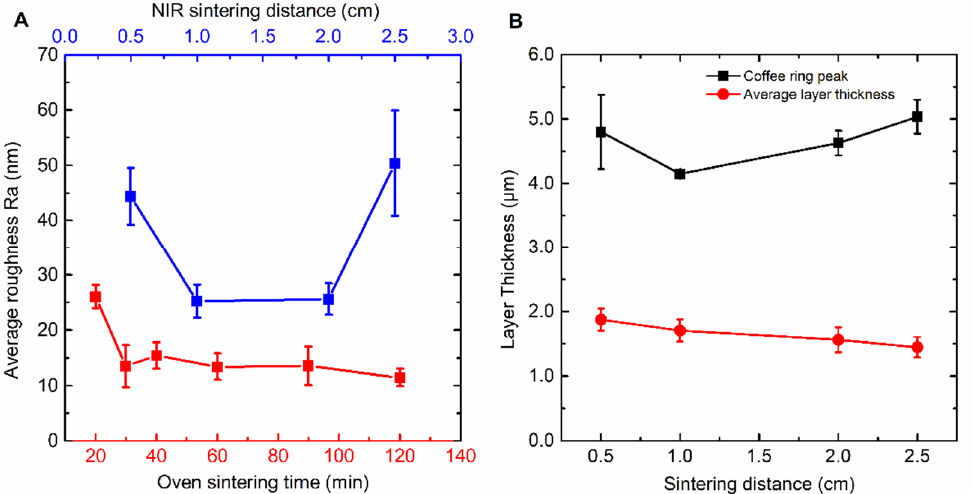
Figure 3. NIR-continuous sintering of JSB40G has an optimal sintering distance of 1 to 2 cm (blue), in order to achieve the lowest average surface roughness (Ra), with slightly higher results compared with conventional oven sintering (red). ( A ) In contrast to oven sintering, NIR sintering of JS-B40G results in the formation of a big coffee ring about two to five times the regular layer thickness. ( B ) Every datapoint consists out of three corresponding samples with every sample measured on two locations with the profilometer (line measurement), the error bars represent the standard deviation.